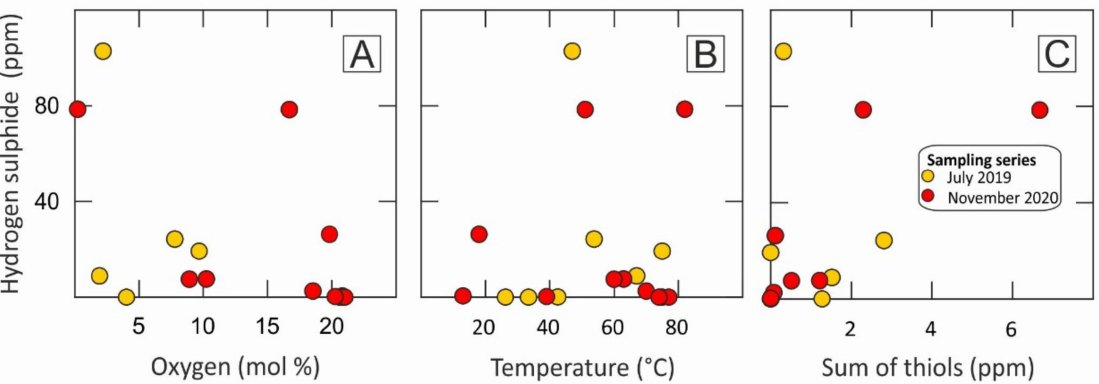
Figure 9. Hydrogen sulphide concentration versus ( A ) oxygen concentration, ( B ) temperature at the point of sampling and ( C ) sum of thiols (methanethiol + ethanethiol +